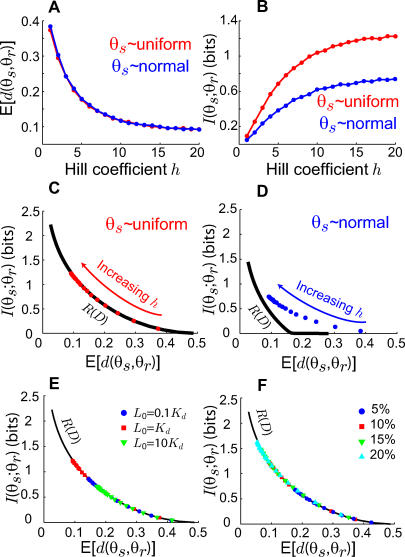
Achievable Performance of the LEGI Model of Gradient Sensing(A) Expected distortion of the LEGI model for various degrees of amplification (characterized by an effective Hill coefficient h) when the probability distribution of the direction of the attractant gradient is uniform (red) and normal (blue).(B) Mutual information between stimulus and response for a uniform (red) and normal (blue) source distribution for varying Hill coefficients.(C–D) Superimposed plots of the best achievable rate (black line) as well as the LEGI model (red and blue circles) for varying Hill coefficients (h) assuming either uniform (C) or normal (D) source distributions.(E–F) Expected distortion versus mutual information for various Hill coefficients (h) under different chemoattractant gradients and a uniformly distributed gradient angle. In (E) the gradient is 10% and the midpoint concentration is 0.1Kd (blue circles), Kd (red squares), and 10 Kd (green triangles). In (F) the midpoint concentration is Kd and the gradient is ±5% (blue circles), ±10% (red squares), ±15% (green triangles), and ±20% (light blue triangles). Parameters used in (A–D) are N = 50, a = 220, b = 20, Kd = 200,
for all i,
, and
45°.